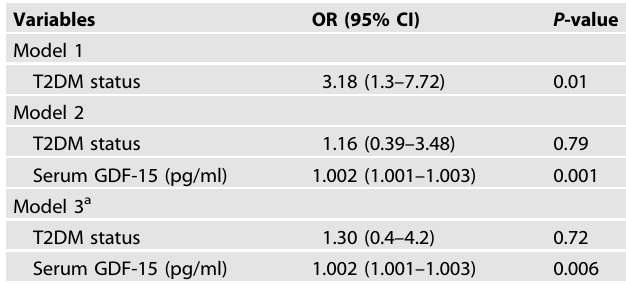
Table 2. Univariable linear associations with serum GDF-15 concentrations.